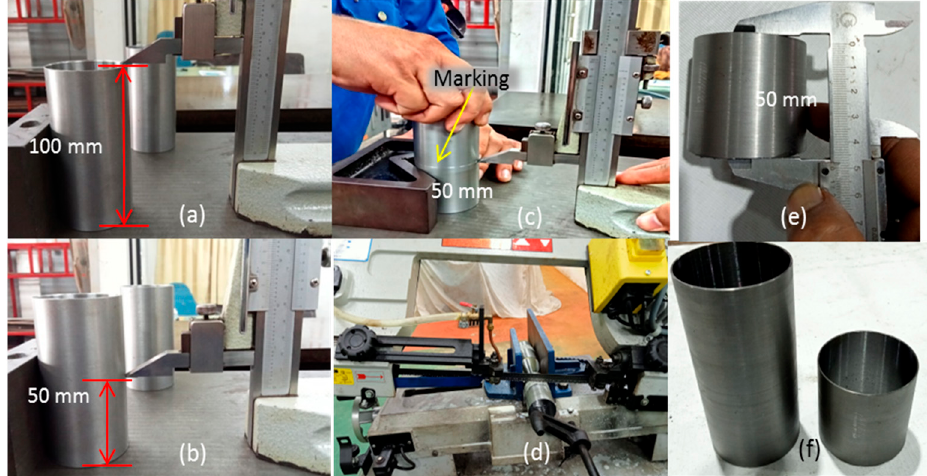
Figure 4. Metal tube preparation for TSPC confinement. ( a ) The 100 mm metal tube height. ( b ) The 50 mm measurement for partial metal tube confinement. ( c ) Marking on 50 mm for cutting preparation. ( d ) Cutting the metal tube in half. ( e ) Finished preparing 50 mm height metal tube. ( f ) Ready metal tube for full and partial confinement process.